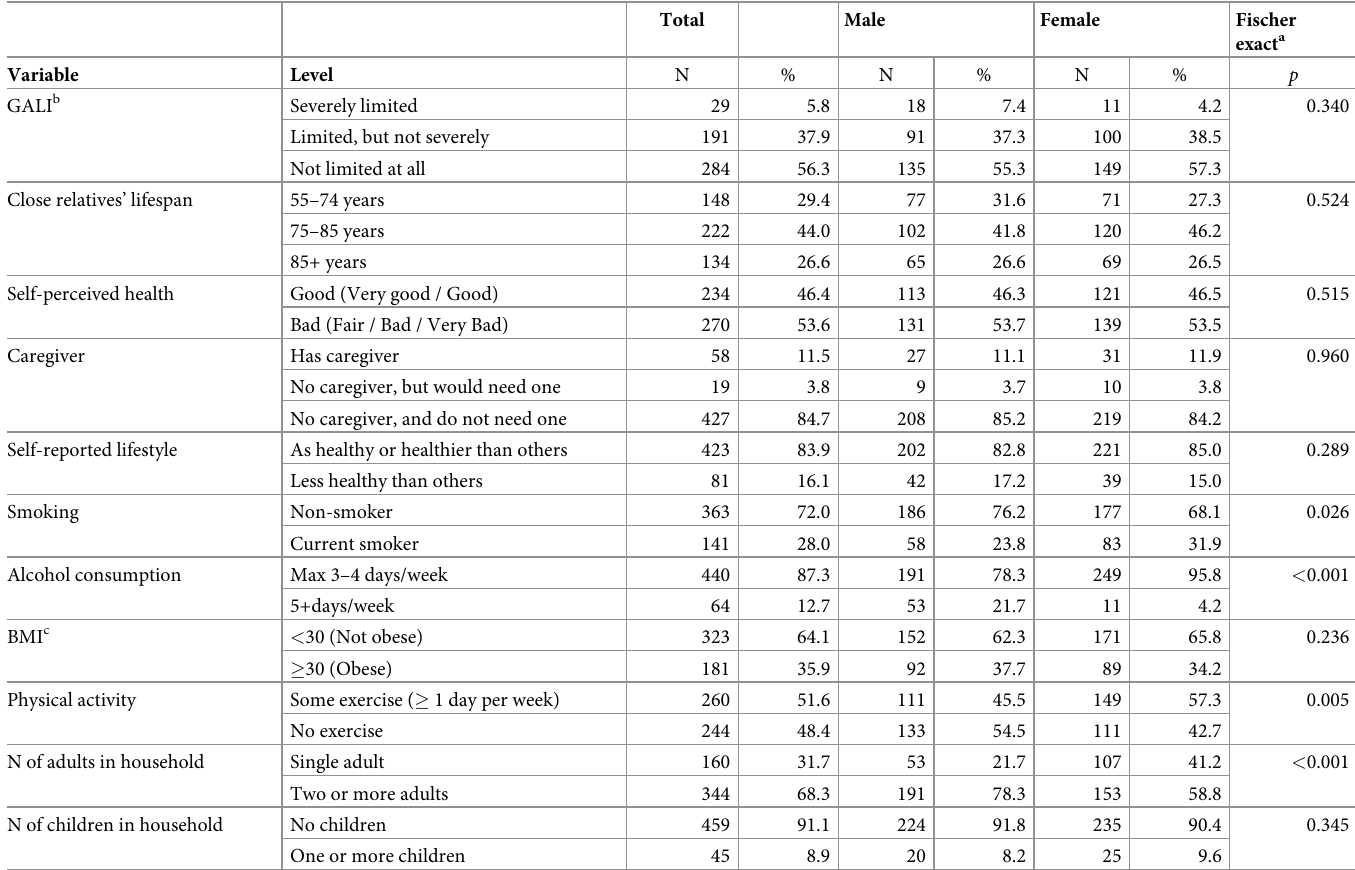
Table 2. Distribution of key explanatory